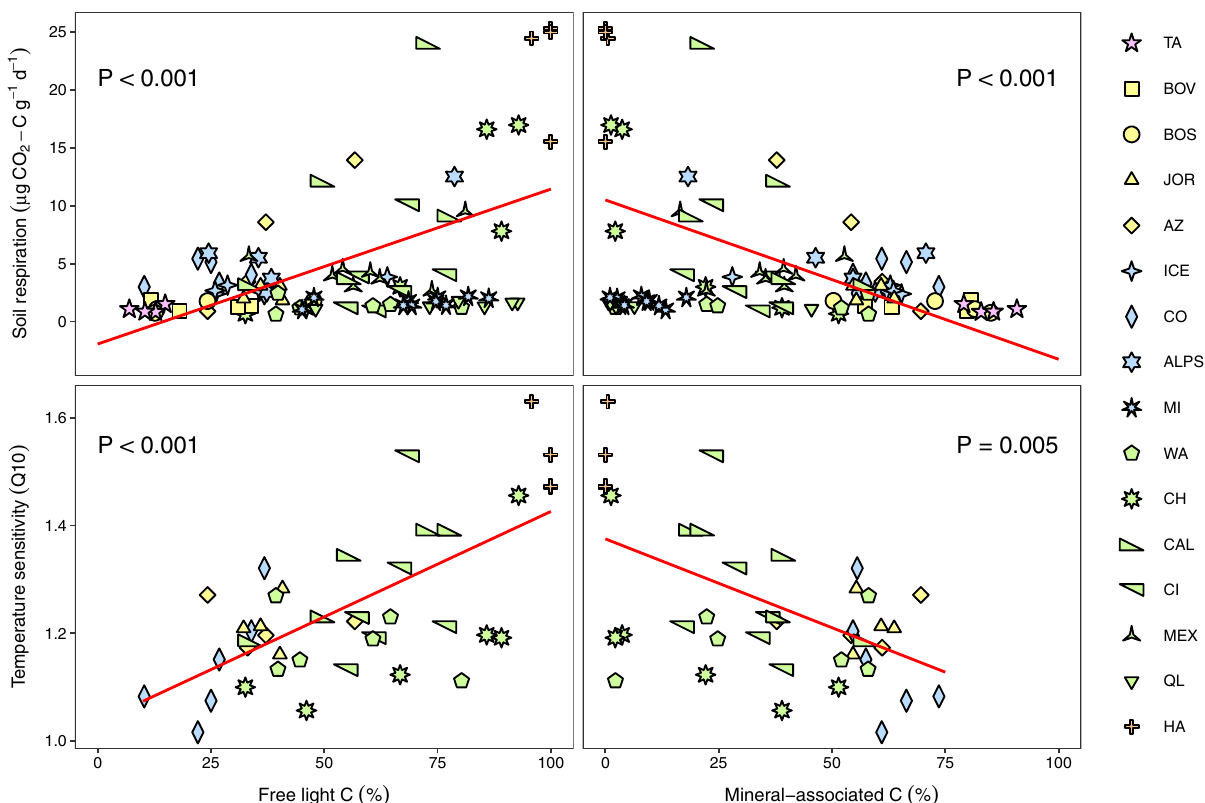
Fig. 2 Relationship between the proportion of free light and mineral-associated carbon fractions and soil respiration and temperature sensitivity of soil respiration. Red lines represent predicted values adjusted for net primary productivity and fi ne texture. Each panel shows the p value for the effect of the corresponding carbon (C) fraction in a linear mixed-effects model that include net primary productivity and fi ne texture as covariates. Proportion of C fraction i (%) = C fraction i content × 100/sum of all C fraction contents.